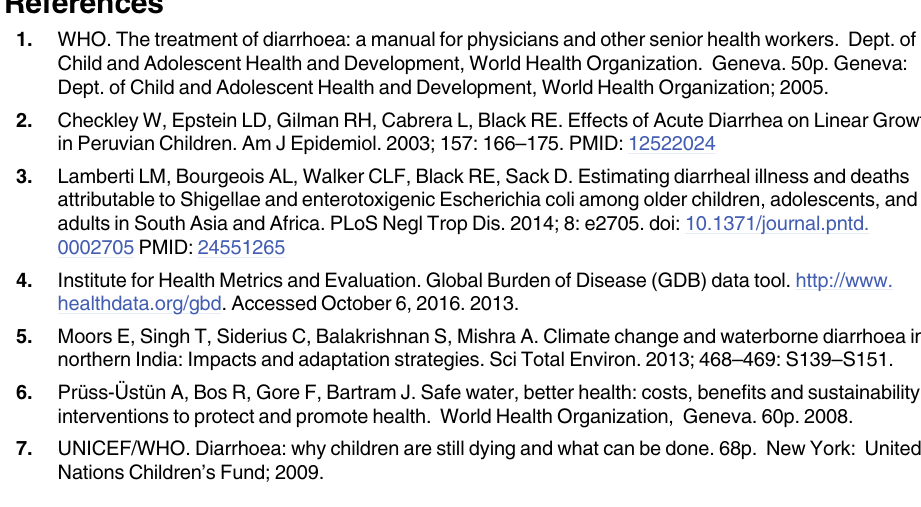
S1 Table. Detail of the stakeholders interviewed. S2 Table. Detail of the villagers interviewed. S3 Table. Villagers interview matrix. S4 Table. Dataset. S5 Table. Reported cases (i.e., hospital admissions) of diarrheal diseases from 2010 to 2012 across Luang Prabang area, Laos, by (1) the age of the patients, (2) their sex and (3) the spatial subset. S6 Table. Effect of environmental variables on total incidence from May 2011 to December 2012. The last 3 columns present the results of the LRT and show the significances of each var- iable, correcting for the potential confounding effects of the other variables. ar1 is the 1-step lagged incidence